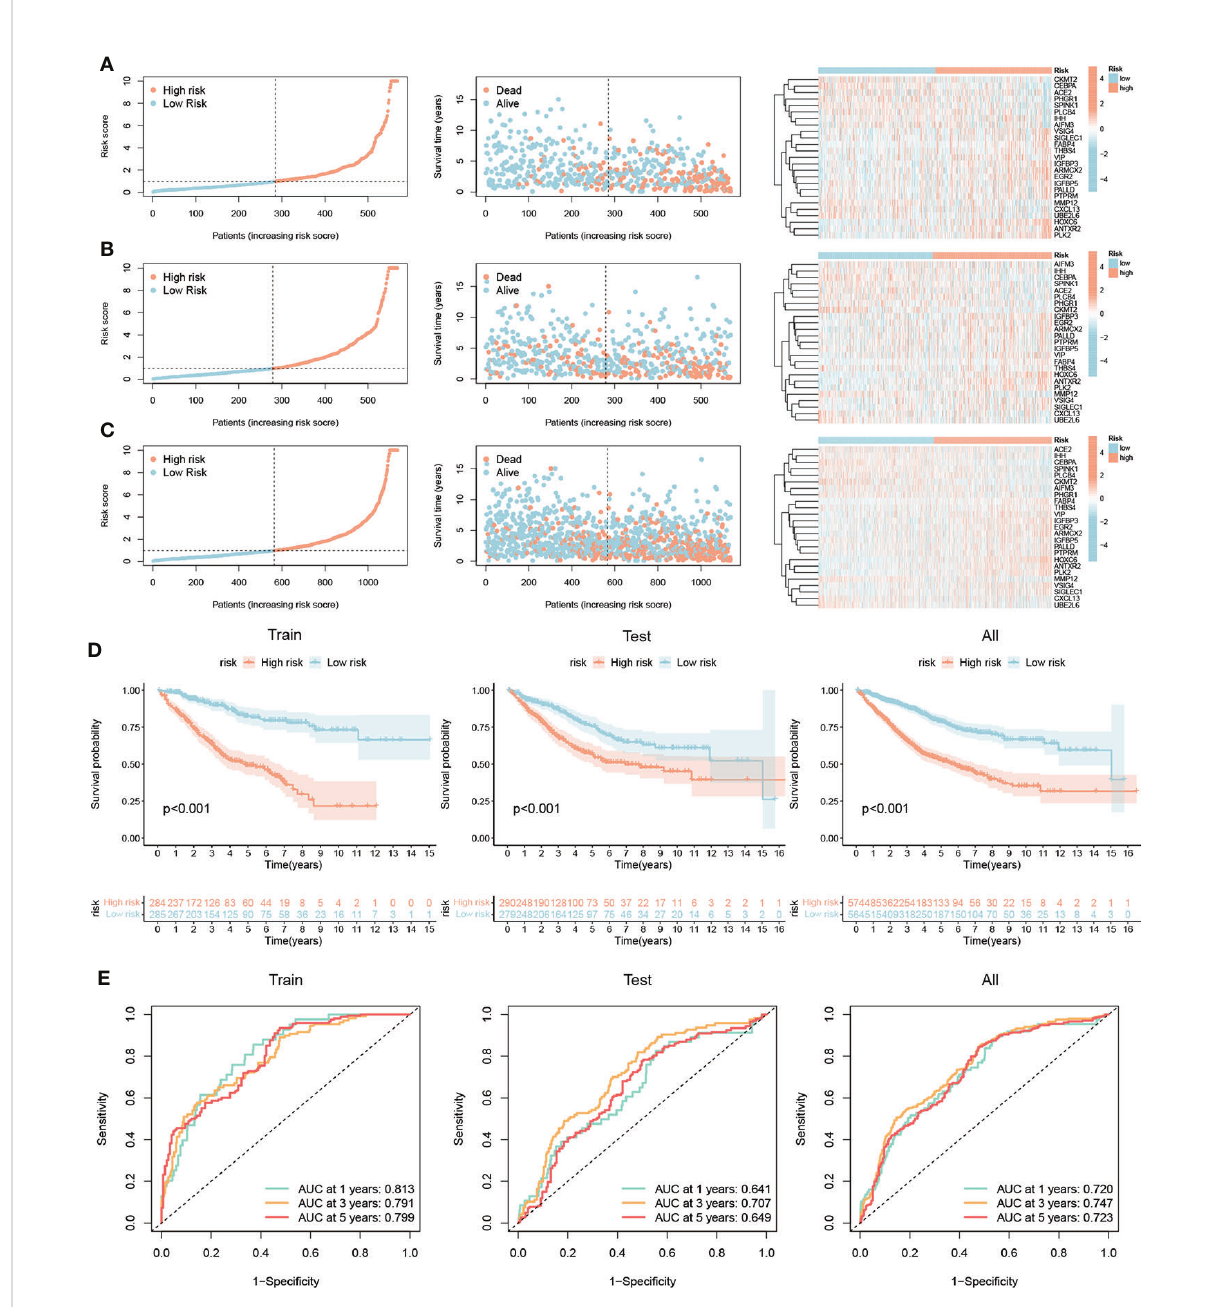
FIGURE 5 Construction of necroptosis-related signature. Ranked dot and scatter plots showing the risk score distribution and patient survival status, and the heatmap showing differential expression of 25 mRNAs in the high-risk and low-risk groups in the training group (A) , testing group (B) , and all sample (C) . (D) Kaplan – Meier analysis of the overall survival between the high and low-risk groups. (E) ROC curves to test the prediction performance of signature of 1-, 3-, and 5-year survival according to the risk